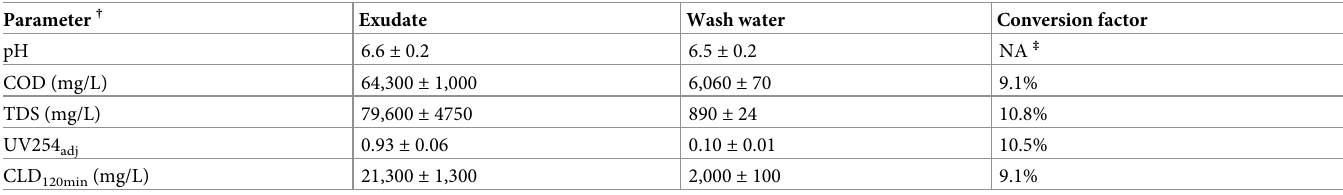
Table 1. Water quality parameters of cabbage exudate and wash